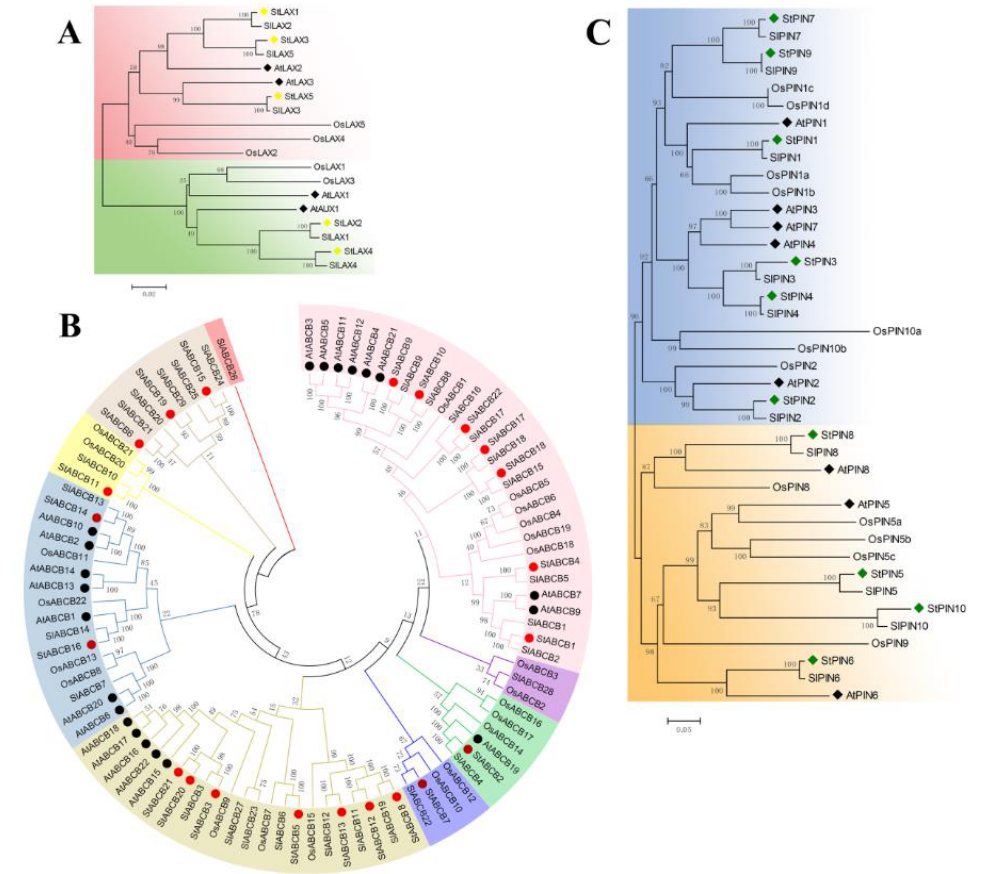
Figure 2. Phylogenetic tree of like auxin resistant 1s (LAXs) ( A ), pin-formed efflux carriers (PINs) ( B ), and ATP − binding cassette B influx/efflux carriers ABCBs ( C ) auxin transporter protein families in Arabidopsis, rice, tomato, and potato. Bootstrap values are presented for all branches. ( A ) LAX protein family: inventory of AtLAX families was based on TAIR databases. ( B ) PIN protein family: sequence data on AtPIN and StPIN families were based on TAIR annotation and Efstathios R’s publi- cation. ( C ) ABCB protein family: inventory of AtABCB families was based on the ABC superfamily reviewed by Verrier et al. Different colors indicated different